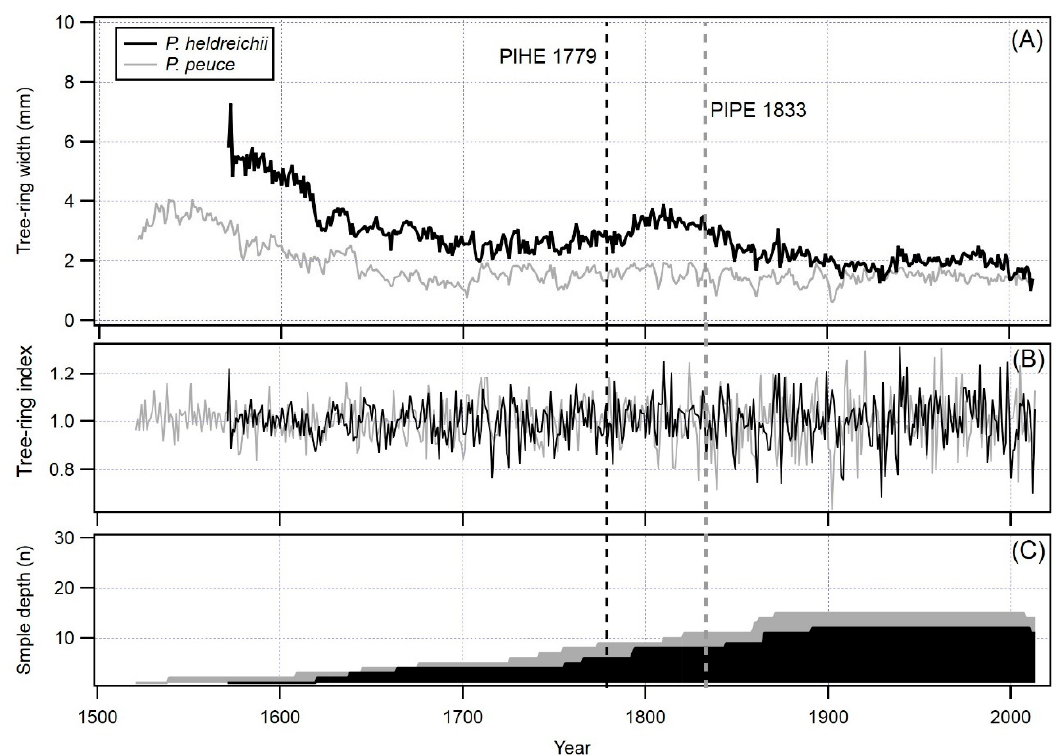
Figure 3. Long tree-ring width chronologies for Pinus heldreichii and Pinus peuce . Vertical dashed lines indicate EPS > 0.85, (A) raw chronologies, (B) standardized chronologies and (C) number of tree-ring width series included in chronologies ( P. heldreichii —black, P. peuce —grey).